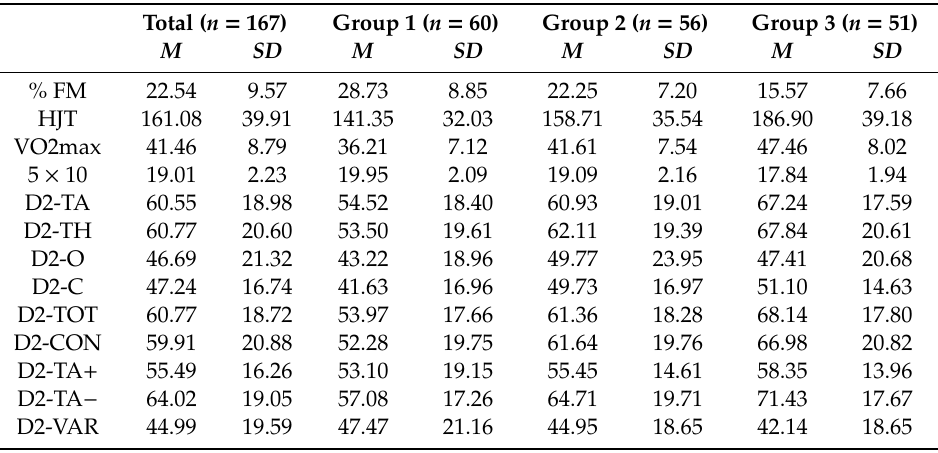
Table 1. Mean and standard deviation of study